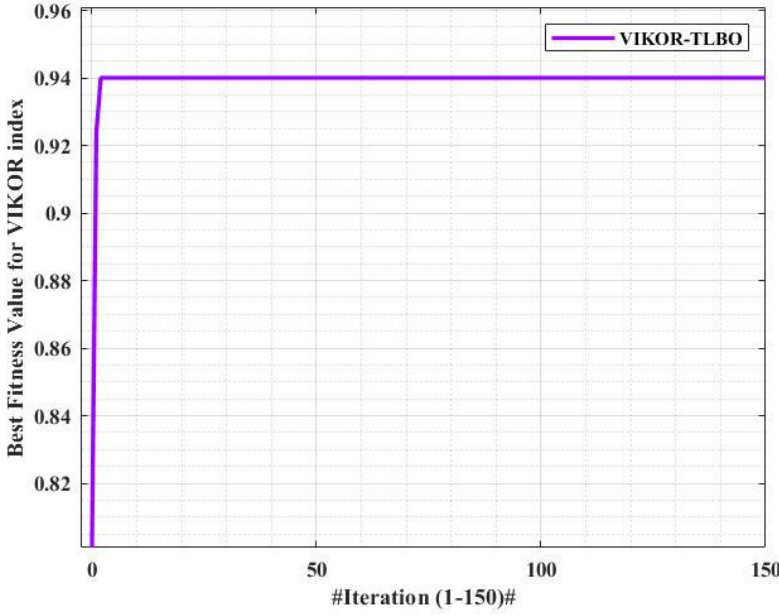
Fig. 11. Convergence plot of VIKOR-TLBO hybrid